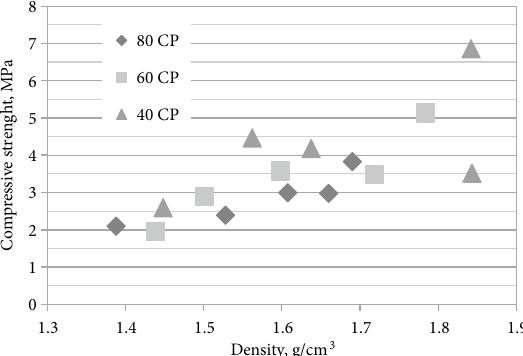
Figure 8. Density and compressive strength dependence on sand admixtures in clay